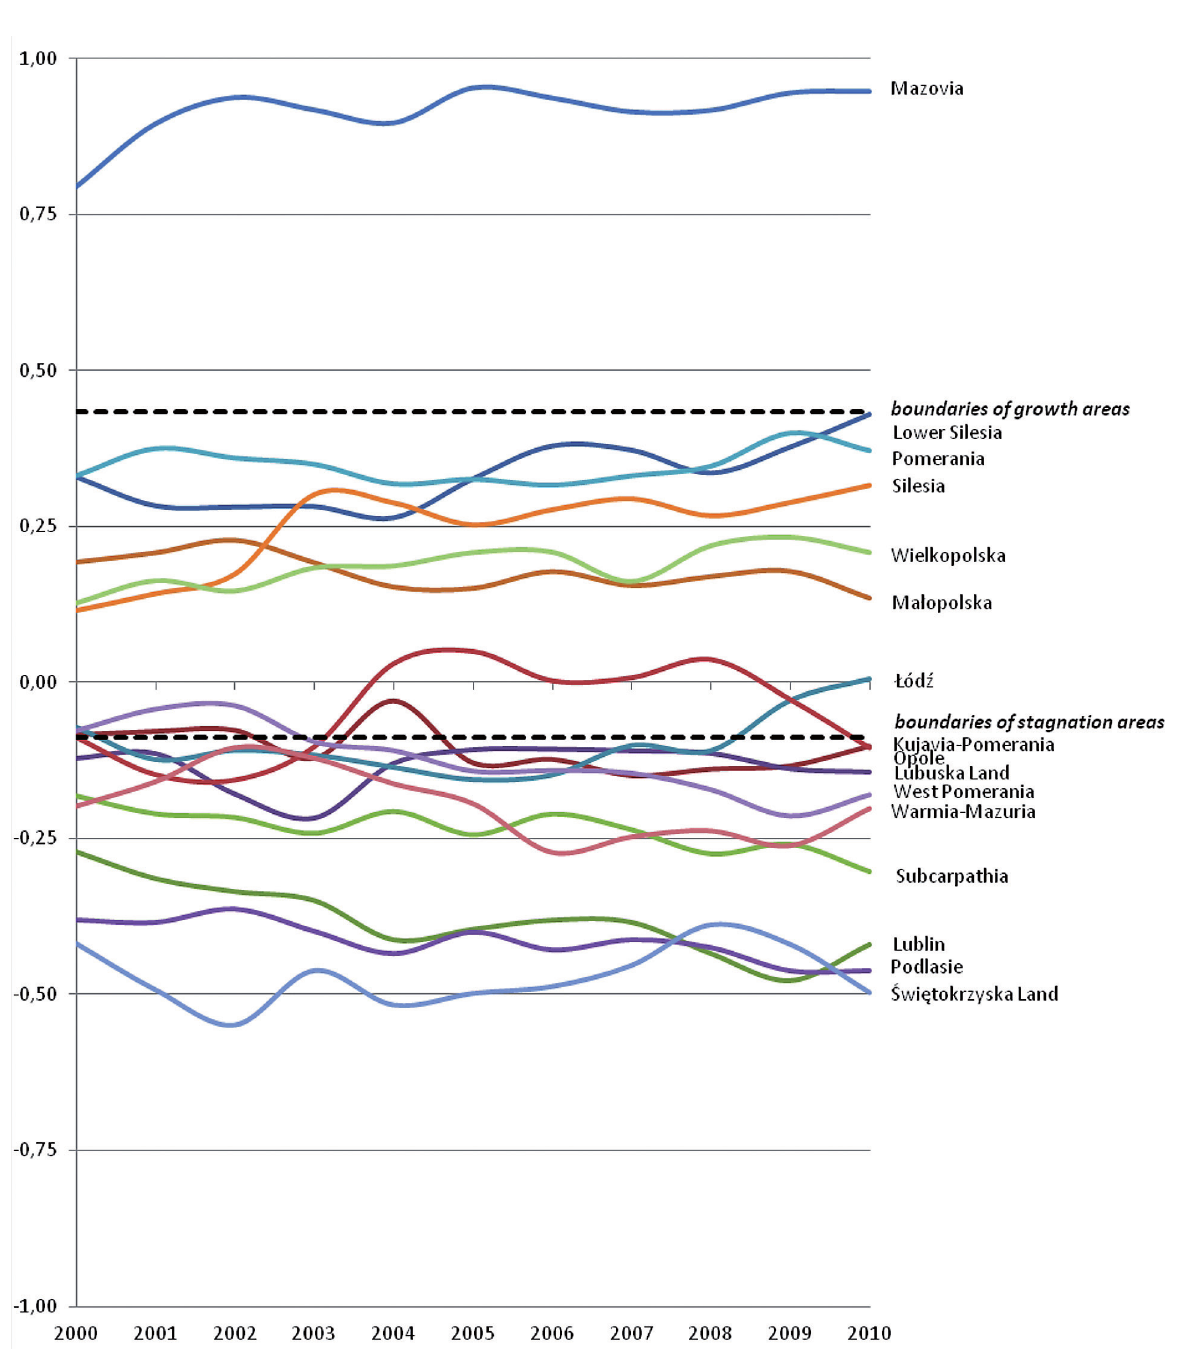
Fig. 4. Development trajectories of voivodeships in the years 2000–2010: a general approach Source: own